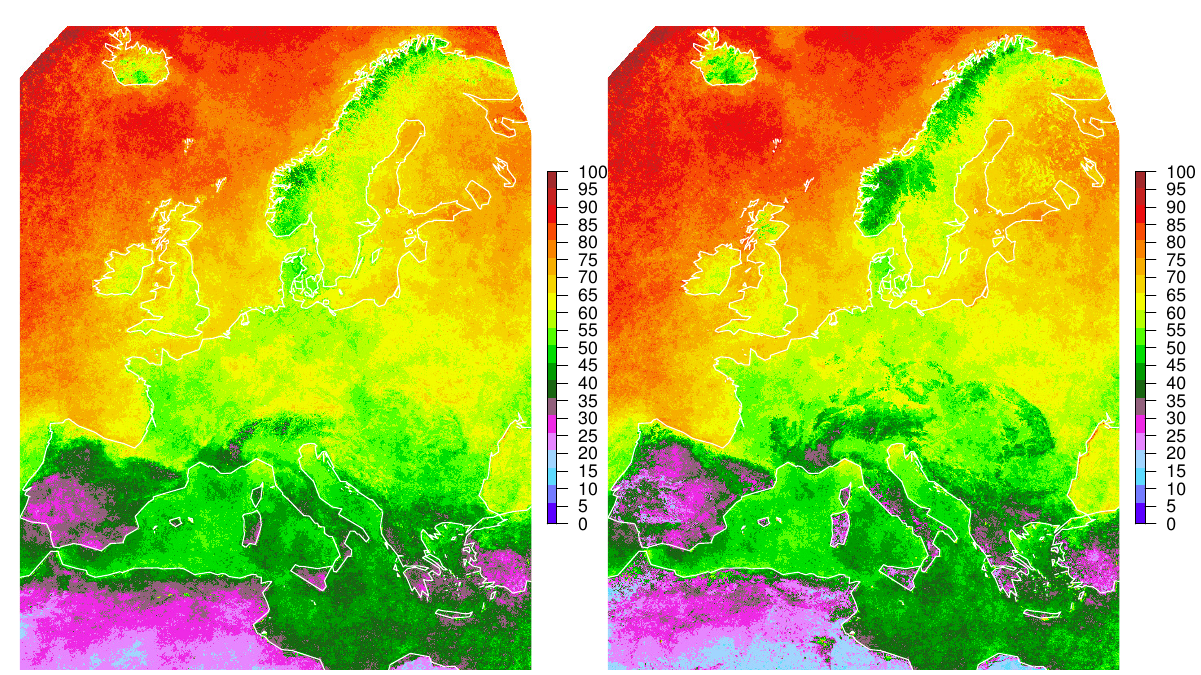
Fig. 10. PCM and PPS annual total cloud cover composites in 2008 derived from the collection of nighttime NOAA18